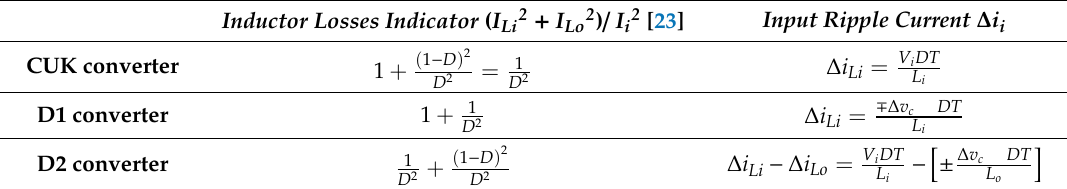
Table 2. Aspects considered for converter e ffi ciency